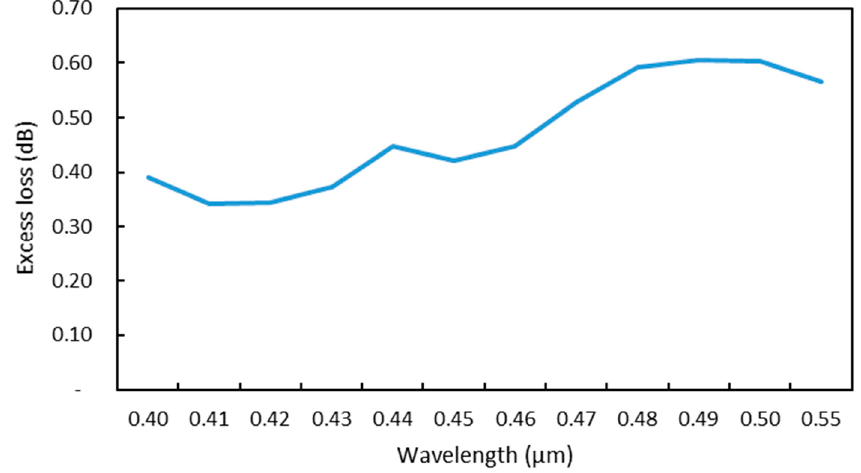
Figure 10. The excess loss of the transverse electric (TE) mode in the proposed optical power divider.